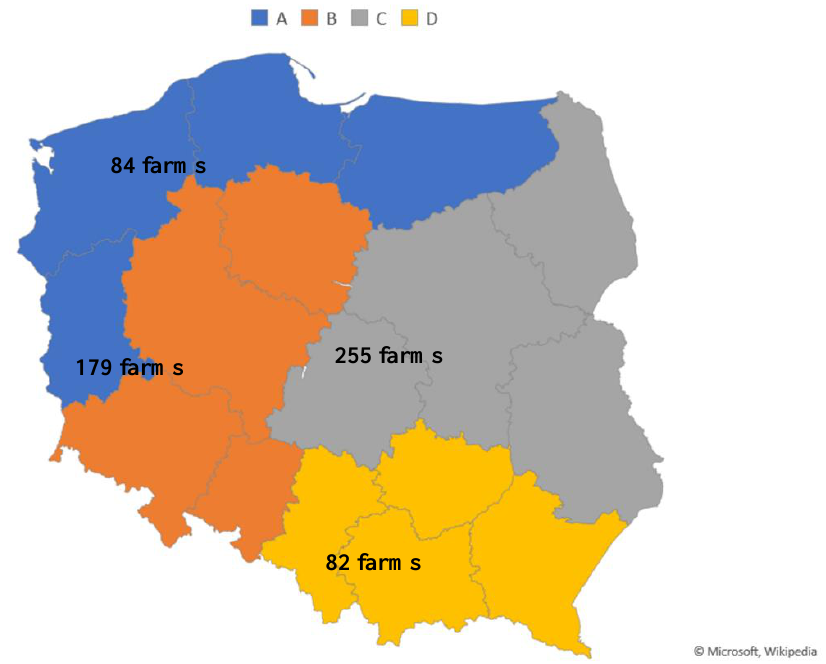
Figure 3. The distribution of surveyed farms within FADN regions in Poland. Source: own research.